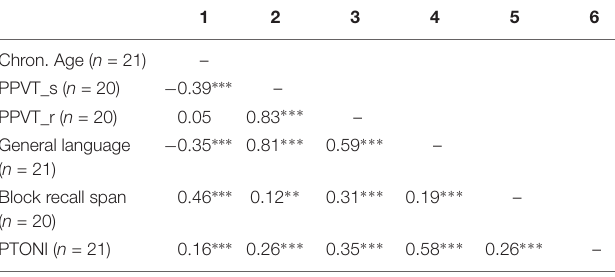
TABLE 4 | Spearman’s correlation matrix for independent variables.